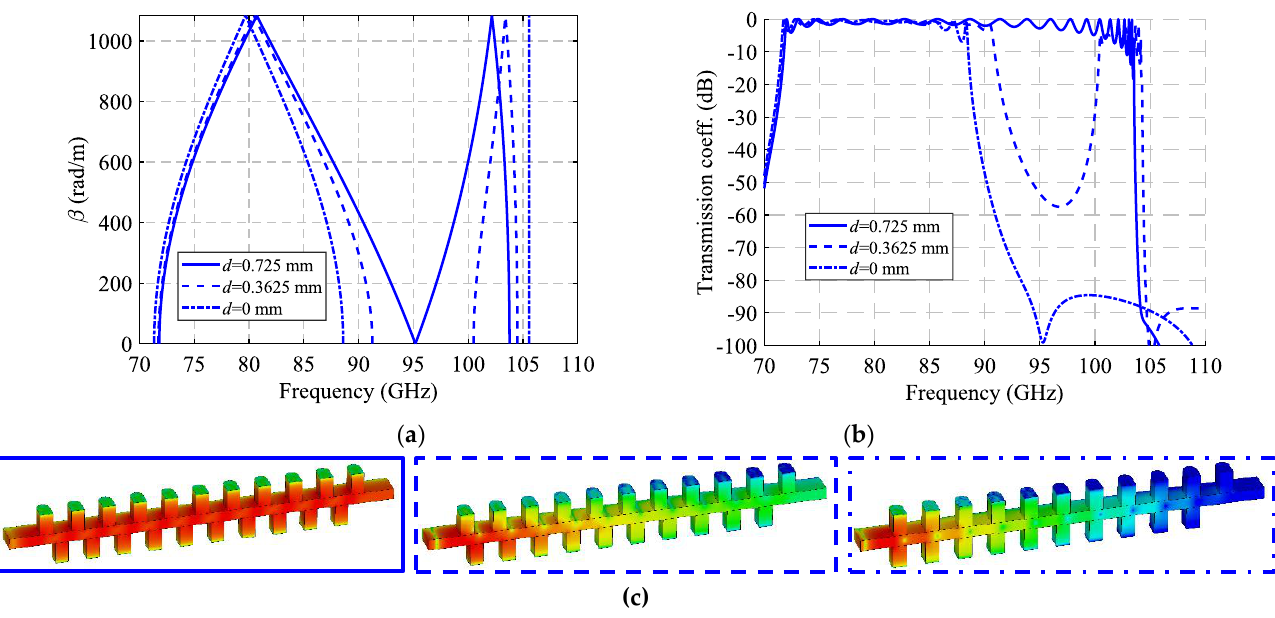
Figure 19. Analysis of the double periodic unit cell for different stages of glide symmetry. ( a ) Phase constant, ( b ) transmission coefficient with N = 10 unit cells and ( c ) electric field level inside the structure at 95 GHz.